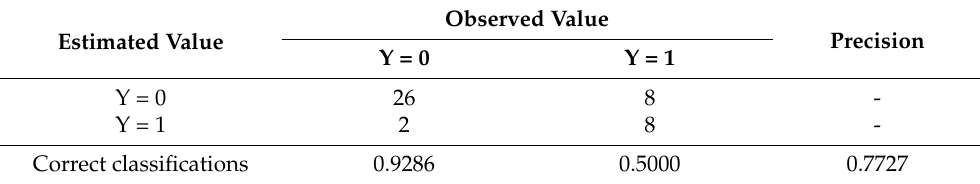
Correct classifications